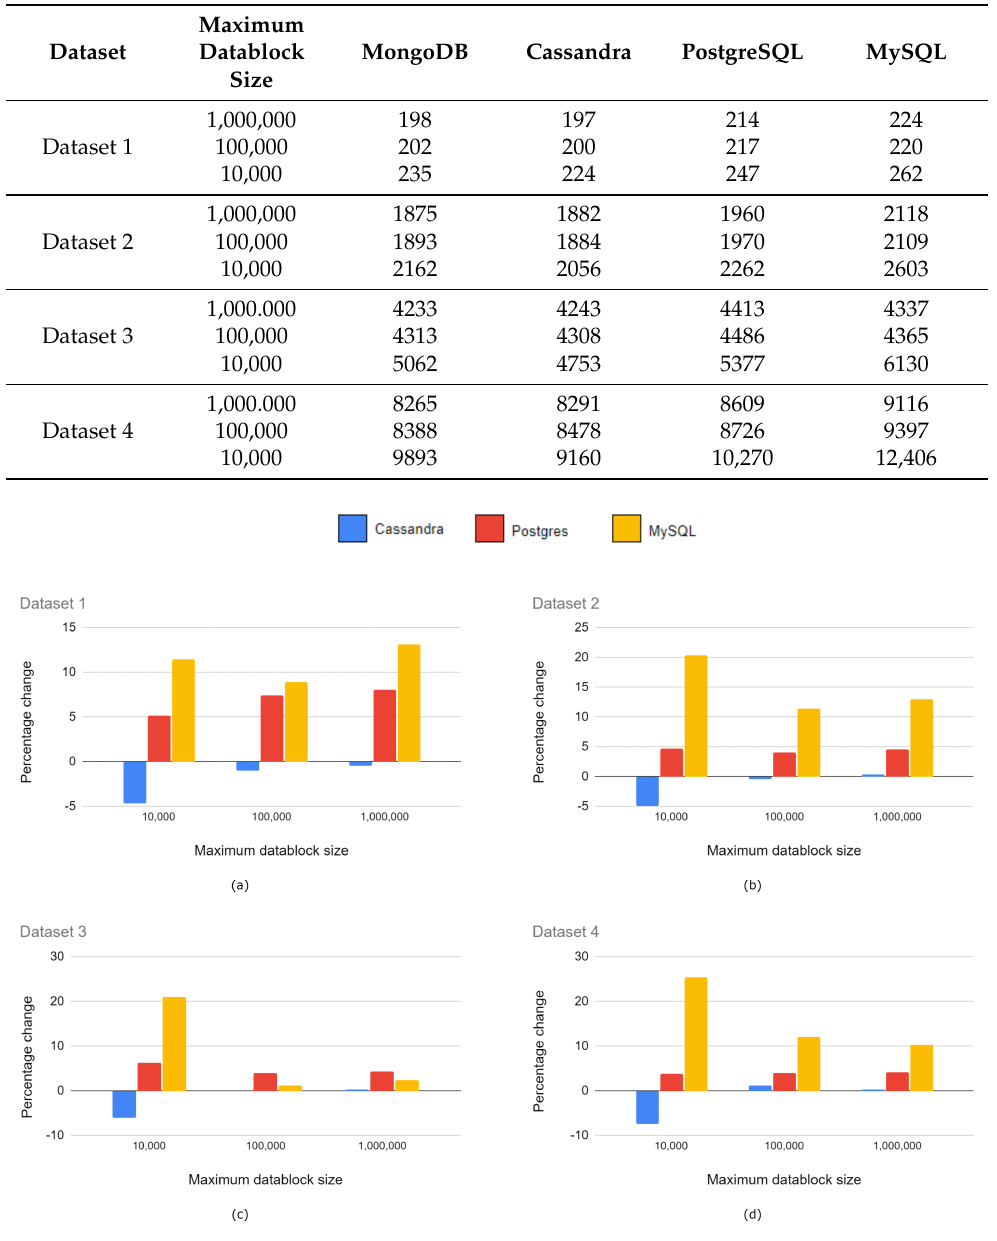
Figure 7. Relative comparison of the required storage. Results for ( a ) Dataset 1; ( b ) Dataset 2; ( c ) Dataset 3; and ( d ) Dataset